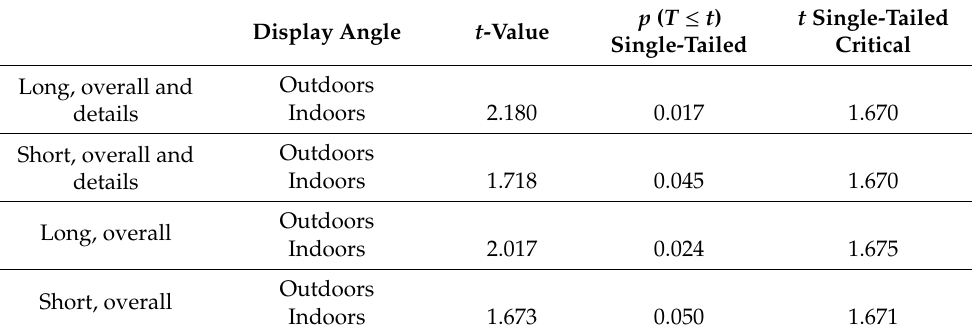
Table 10. The t -tests for di ff erent scenarios’ impacts on consumers’ perceptions of quality. p ( T ≤ t ) t Single-Tailed Display Angle t -Value Single-Tailed Critical 2.180 0.017